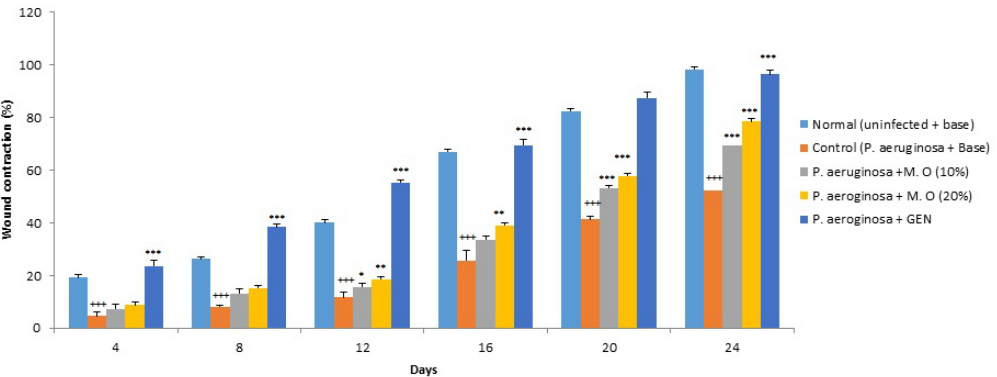
Figure 7. Effect on wound contraction in P. aeruginosa -infected diabetic animals. All values are mean ± SEM, n = 12, +++ p < 0.001 when compared to normal (uninfected). * p < 0.05, ** p < 0.01, *** p < 0.001 when compared to control (infected). M.O = M. oleifera leaf extract formulation, GEN = gentamicin (0.1% w / w ).